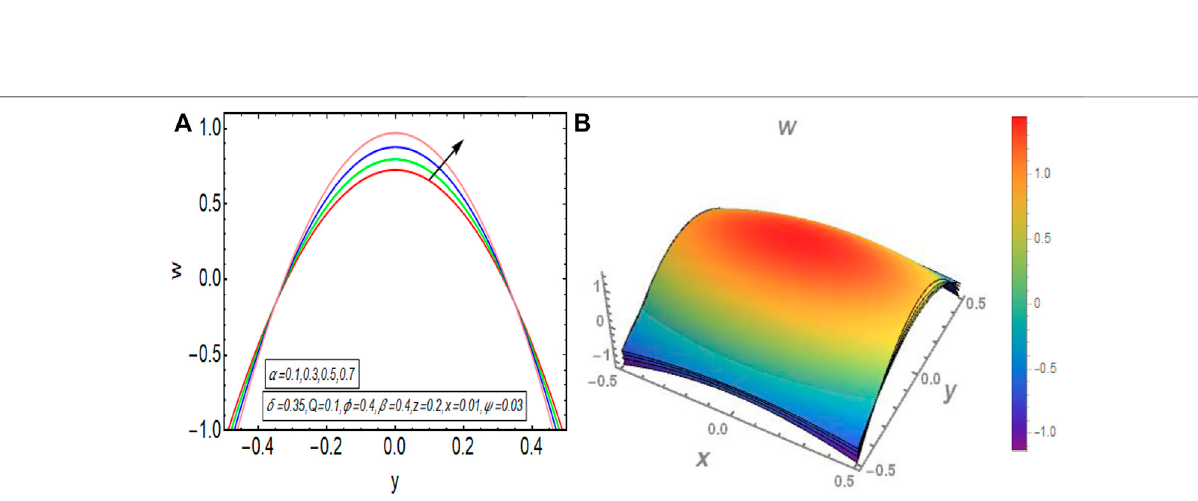
FIGURE 4 | (A) 2D-velocity plot for wavenumber . (B) 3D-velocity plot for wavenumber .